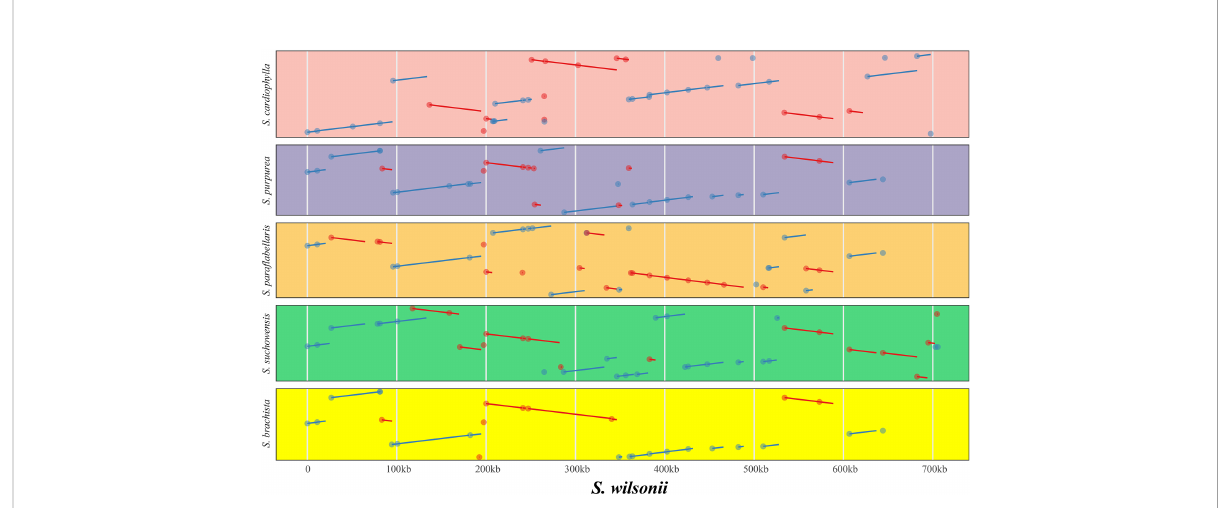
FIGURE 4 Covariance analysis of six different species in the genus Salix using S. wilsonii as the reference genome. The pink, purple, gold, green, and yellow represent the covariate regions of S. wilsonii vs. S. cardiophylla , S. wilsonii vs. S. purpurea , S. wilsonii vs. S. para fl abellaris , S.wilsonii vs. S. suchowensis , and S. wilsonii vs. S. brachista , respectively. The red and blue lines indicate forward and inverted covariance,